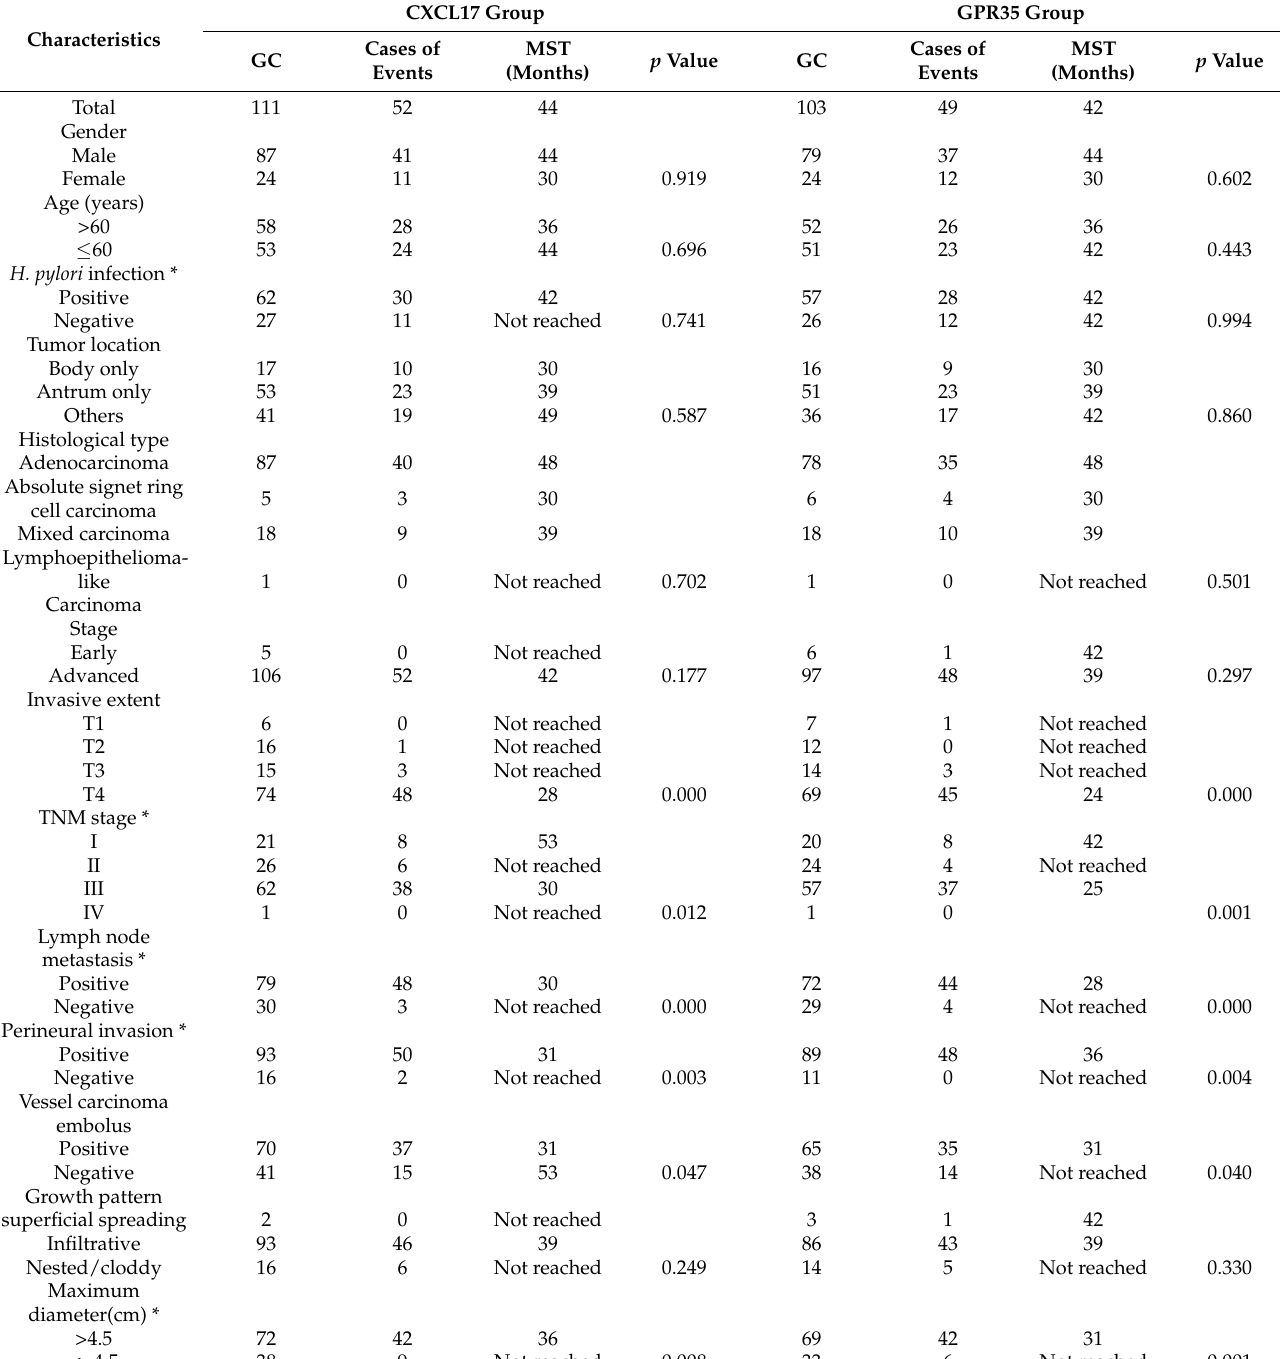
Table 1. Clinicopathological parameters and survival in